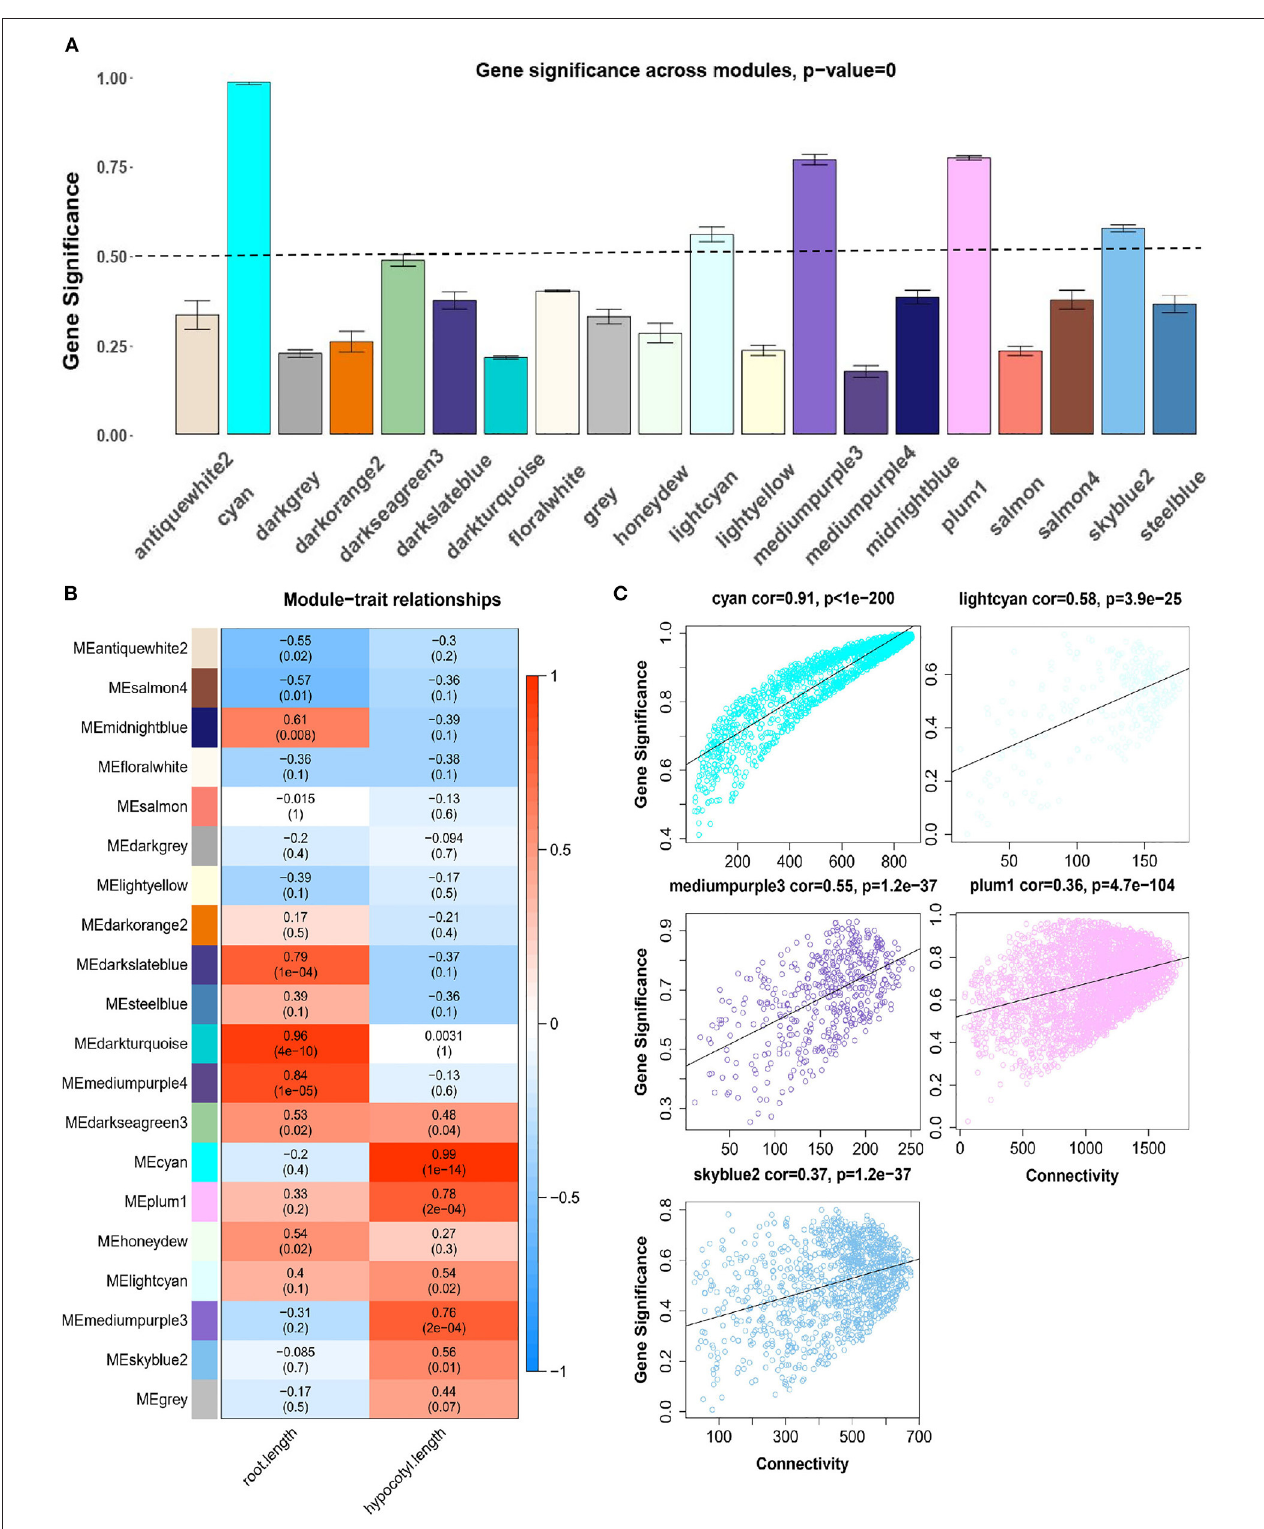
FIGURE 2 | Correlation between modules and traits. (A) The mean gene significance between module and hypocotyl development. (B) Module-trait relationship. Each row corresponds to a module, while each column corresponds to the root/hypocotyl development trait. Each cell contains a corresponding correlation. (C) The correlation between gene significance and connectivity in the 5 modules with gene significance > 0.5 in (A) .